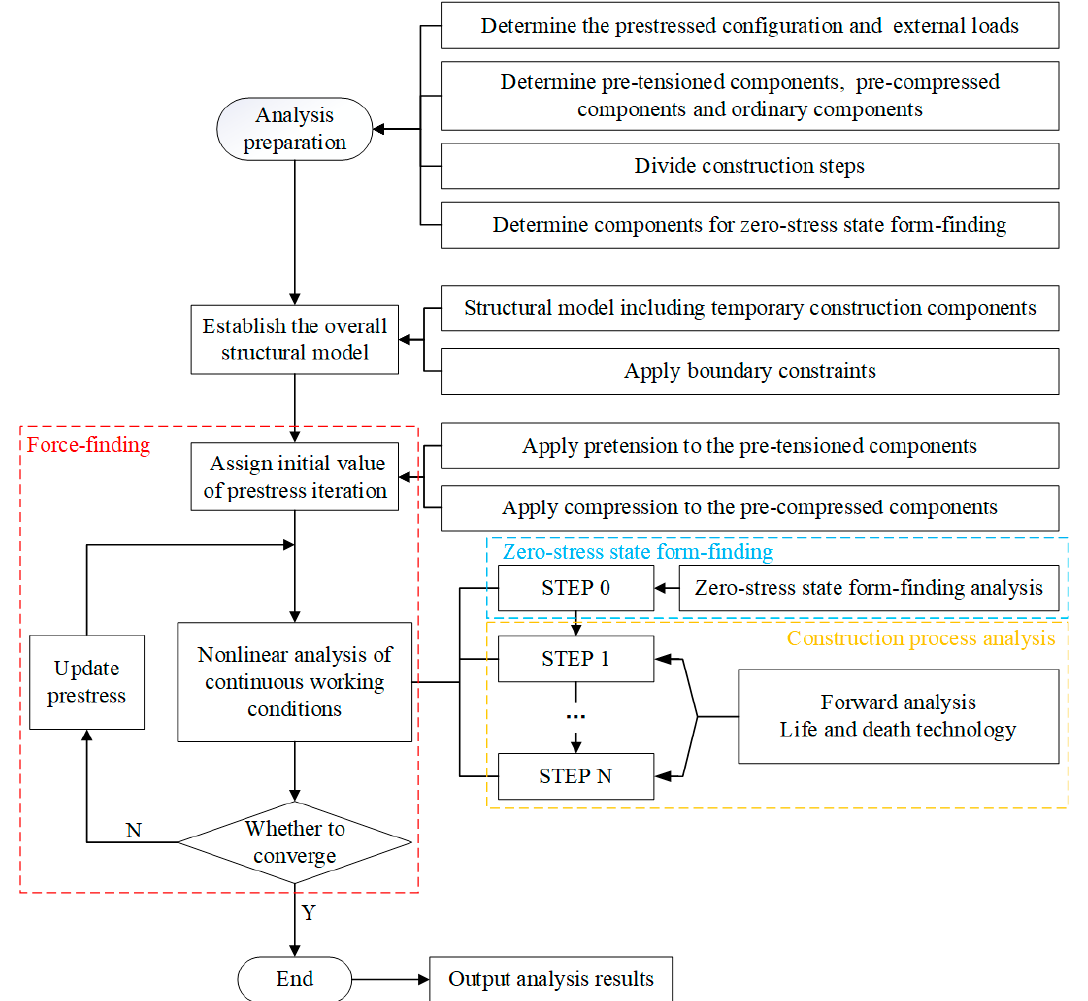
Figure 3. Flow chart of the PSEFF.